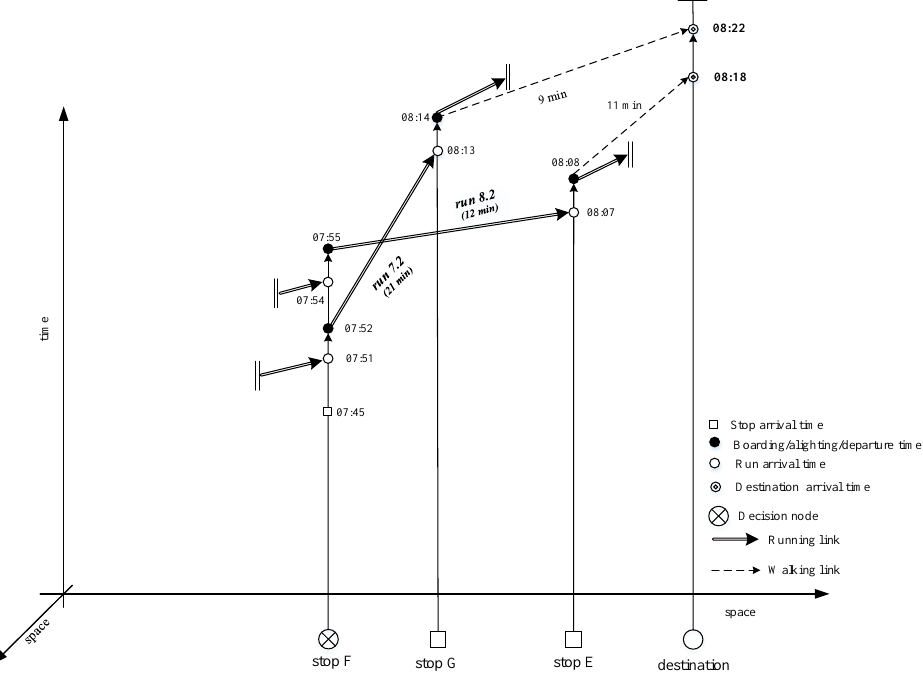
Figure 11. Run-based representation of transit services from node F with forecasted bus arrival times at the following node.